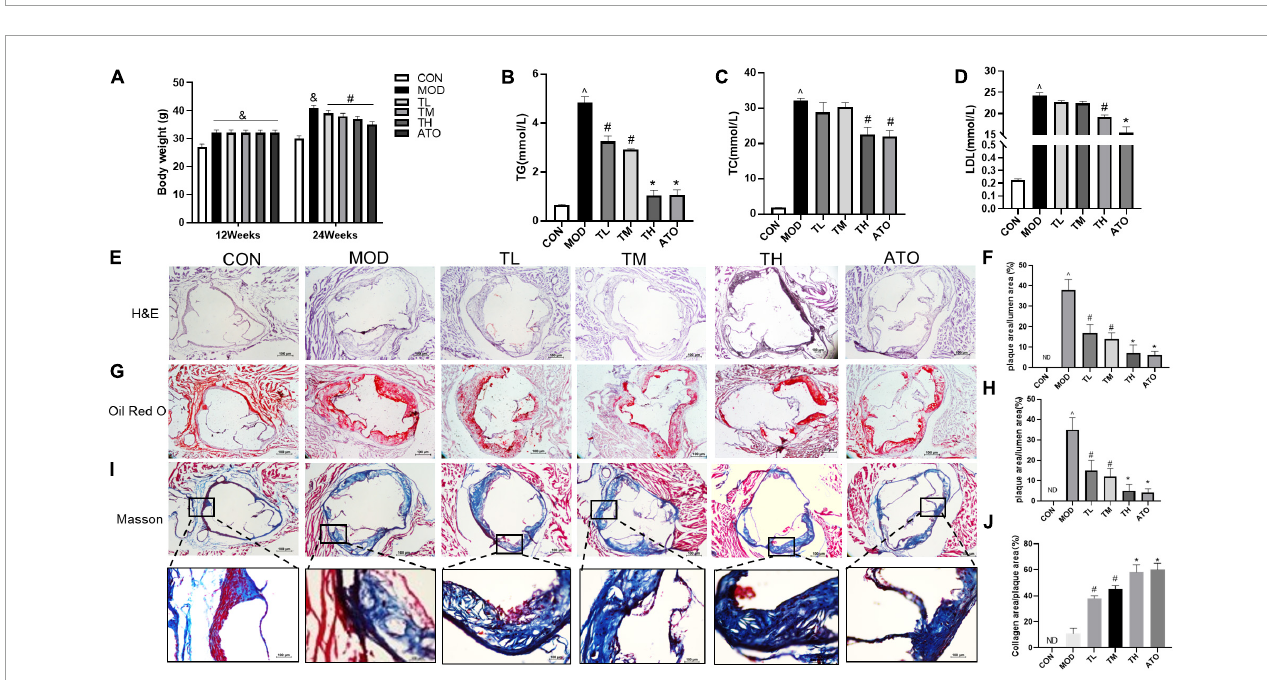
FIGURE9 THD improved the AS mice phenotype. (A) THD attenuates body weight in mice. (B–D) Effect of THD on blood lipids in mice. H&E staining (E) and Oil Red O staining (G) were used to visualize lipid-rich plaque progression. Scale bar = 100 µ m (40 × ). (I) The collagen content was determined by Masson staining. Scale bar = 100 µ m (40 × , Enlarged 200 × ). The areas of the lesion (F–H) and collagen content (J) were calculated, respectively, by Image J. Data are presented as the mean ± SEM ( n = 3). ∧ P < 0.01 vs. CON group; # P < 0.05, * P < 0.01 vs. MOD group. ND, not detected.